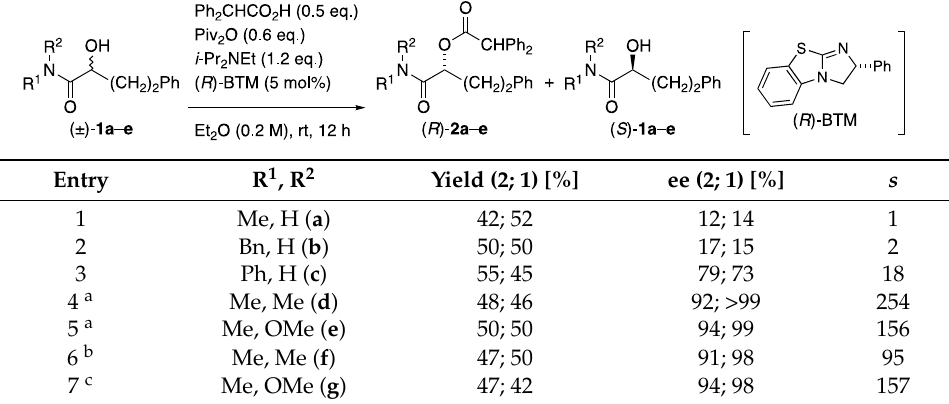
Table 1. Kinetic resolution (KR) of various racemic 2-hydroxyamides ((±)- 1a – 1e ).